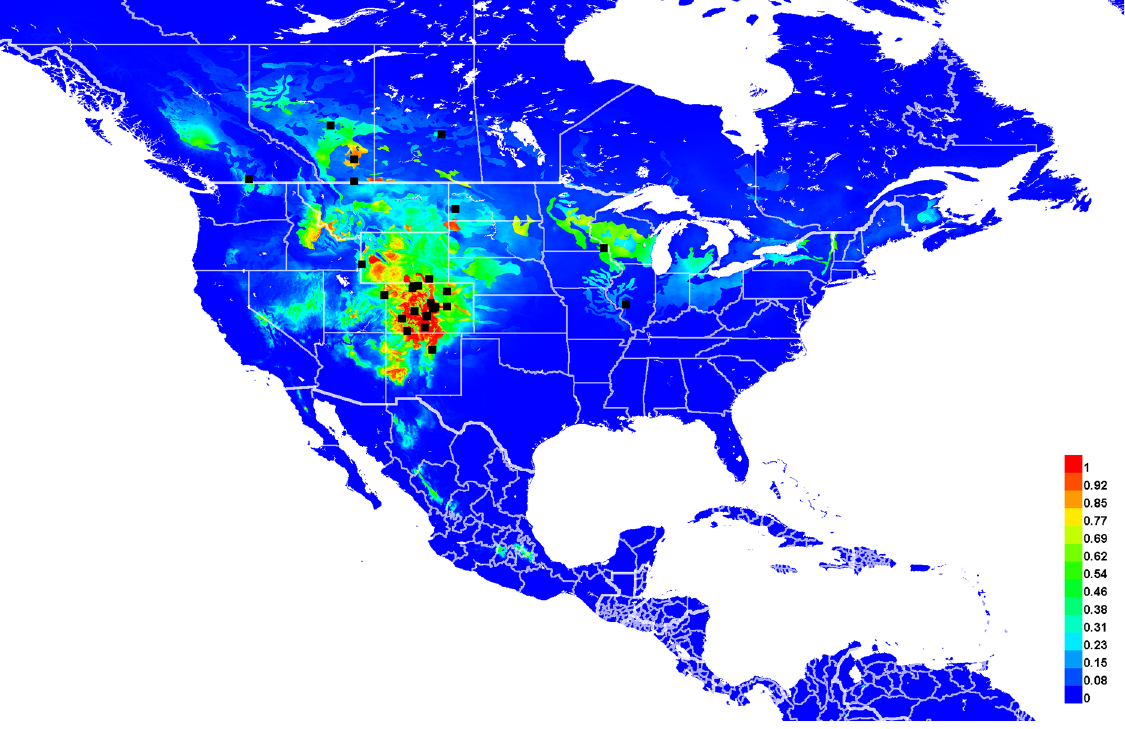
Fig. 84. Georeferenced collection records of Lasioglossum ( D. ) testaceum (Robertson, 1897) (black squares) and predicted distribution by maximum entropy ecological niche modeling in Maxent (colour shading). Warmer colours indicate higher cloglog probability of